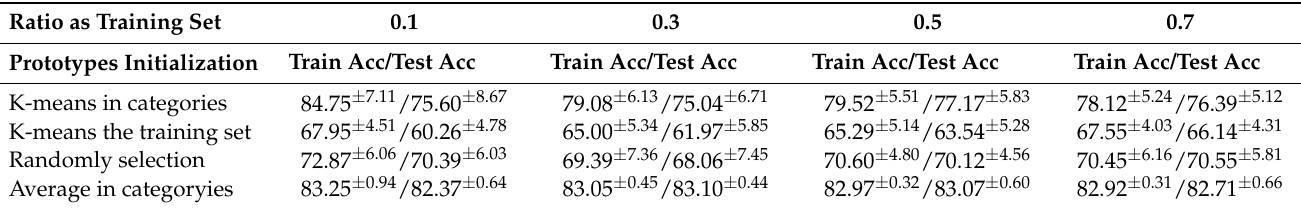
Table 4. The classification accuracy (%) under different prototype initialization methods on Pendigits dataset. The ratio of training samples varies from 0.1 to 0.7. All results are the summary of repeated six runs on different training sets. Ratio as Training Set 0.1 Prototypes Initialization